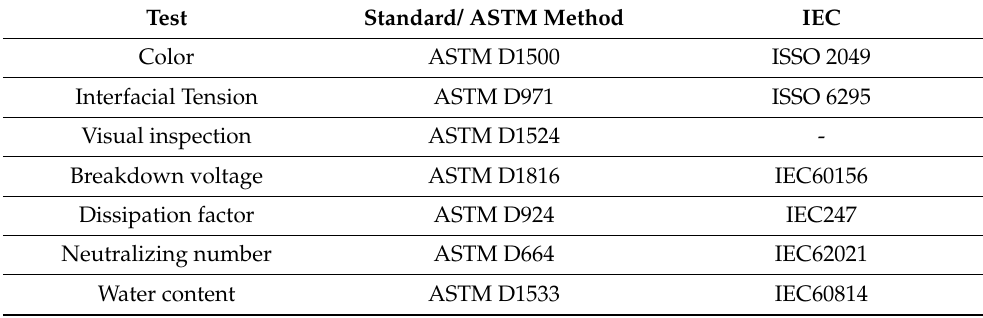
Table 9. Oil quality tests and standards/methods. Adapted from [59], licensed under CC BY